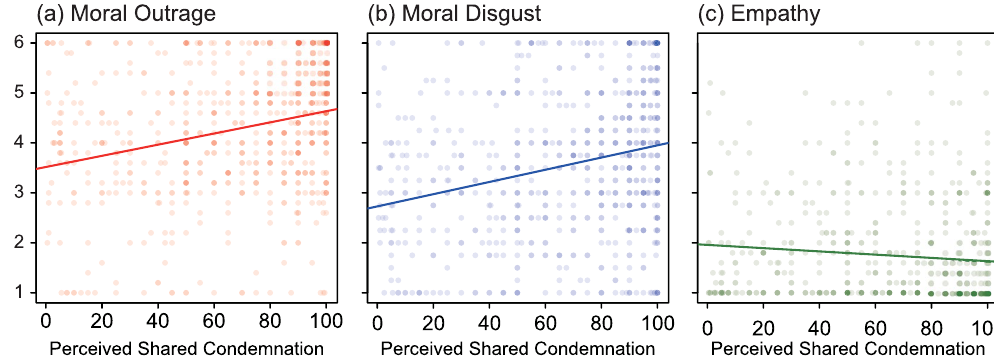
Figure 3. Scatter Plots Showing the Relationship between Perceived Shared Condemnation and Three Moral Emotions in Study 3. ( a ) Moral outrage, ( b ) moral disgust, and ( c )